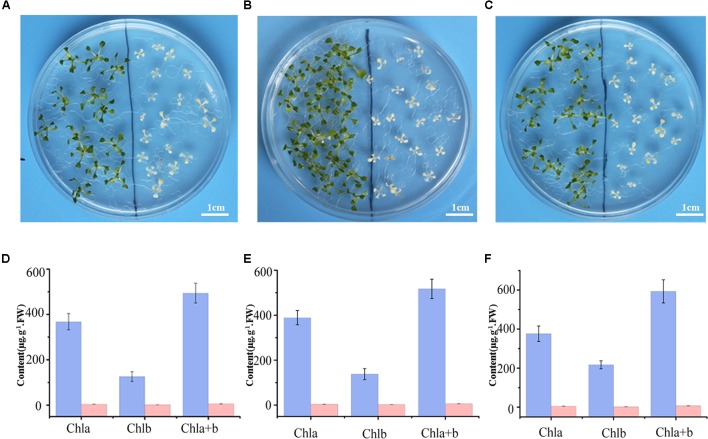
Complement analysis of compound intermediates in the shikimate pathway. Phenotype of wild-type (left), and skl1-8 seedlings (right) grown in (A) the regular MS medium, (B) the presence of chorismate, and (C) shikimate 3-phosphate. The chlorophyll contents in Arabidopsis seedlings were showed in (D–F), respectively, and the data are mean values of three measurements ± SD.